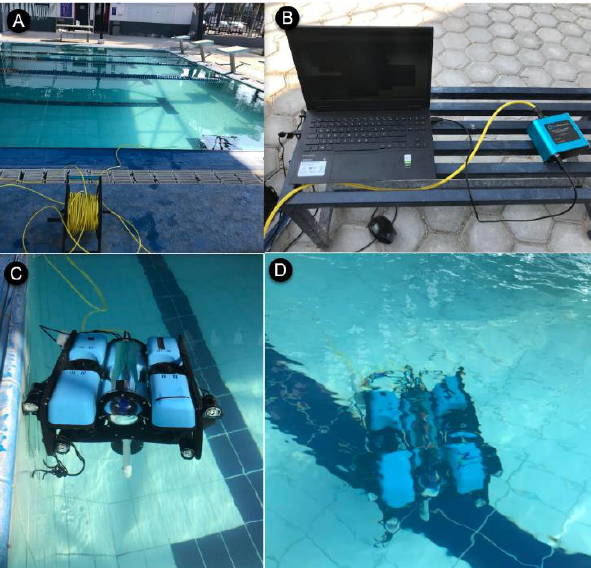
Figure 7. Experimental set-up. ( A ) Semi-Olympic swimming pool. ( B ) Control station. ( C ) BlueROV2 deployment. ( D ) Station-keeping task execution.